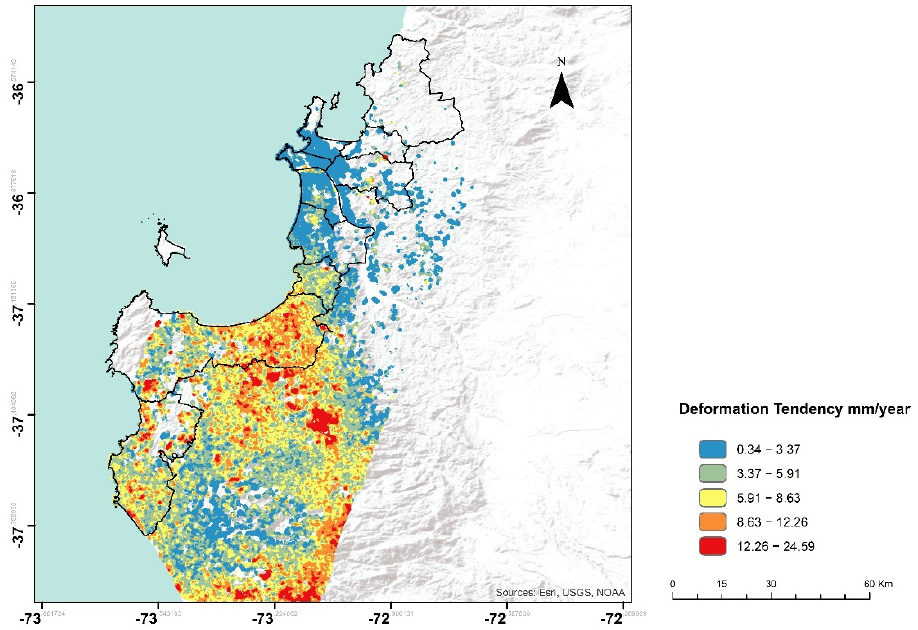
Figure 7. Deformation of tendency map for the study area.